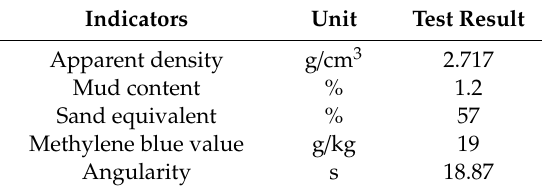
Table A2. Technical indicators of fine aggregate.